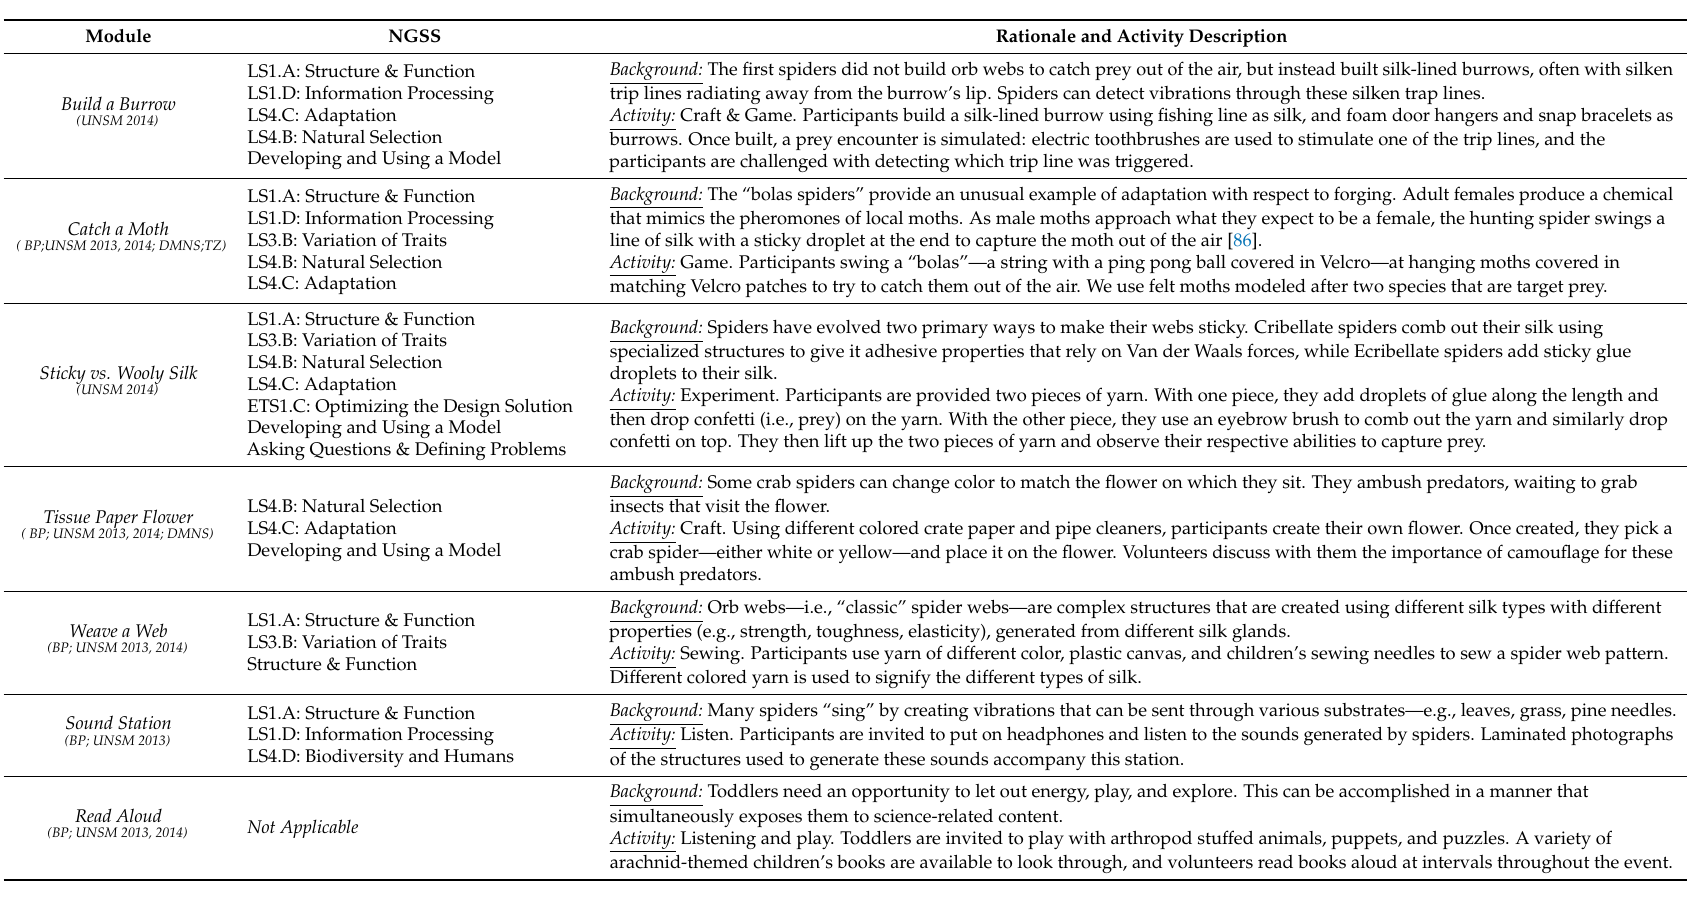
Table 3. Spider and Silk Activities, alignment with NGSS (Disciplinary Core Ideas, Science & Engineering Practices, Cross-Cutting Concepts), and brief descriptions. Superscript abbreviations represent the venues where activities were incorporated (Butterfly Pavilion, CO 2013 BP ; University of Nebraska State Museum—Morrill Hall, NE UNSM 2013, 2014 ; Denver Museum of Nature and Science, CO 2014 DMNS ; Toledo Zoo 2017 TZ ).